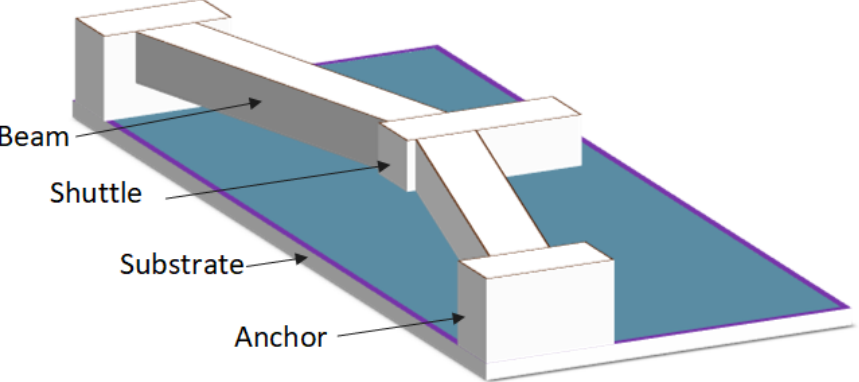
Figure 4. Schematic diagram of the proposed chevron-shaped electro-thermal actuator.